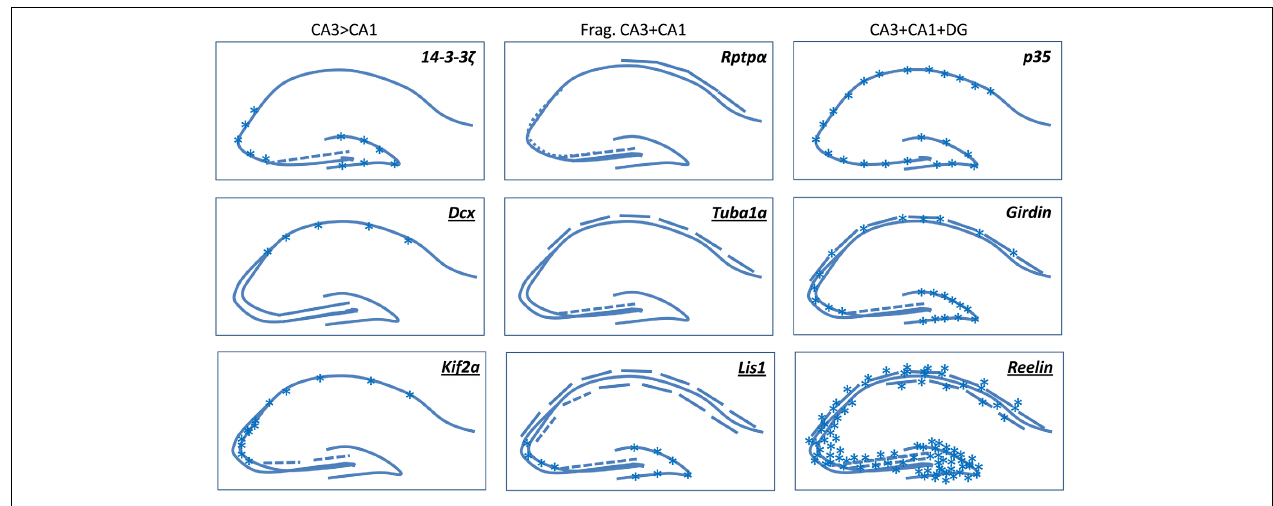
FIGURE 2 | A selection of mouse mutants showing somal lamination defects in the hippocampus. Underlined genes are known to be involved in cortical malformations in human. Frag, Fragmented. Broken lines indicate degrees of fragmentation. Asterisks indicate either heterotopic cells or diffusely packed cells. Schemas based on images presented in the following